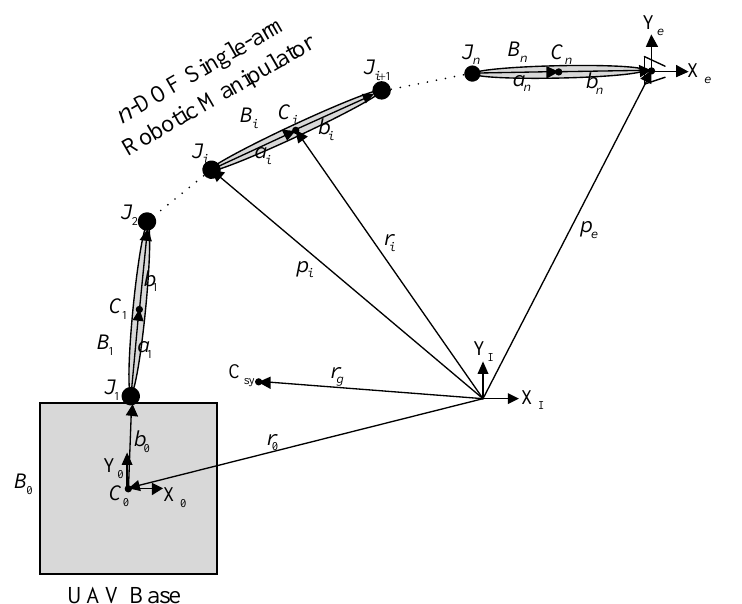
Figure 2. 2-D sketch of an AEROM system, with symbols employed for the derivation of AEROM mathematical